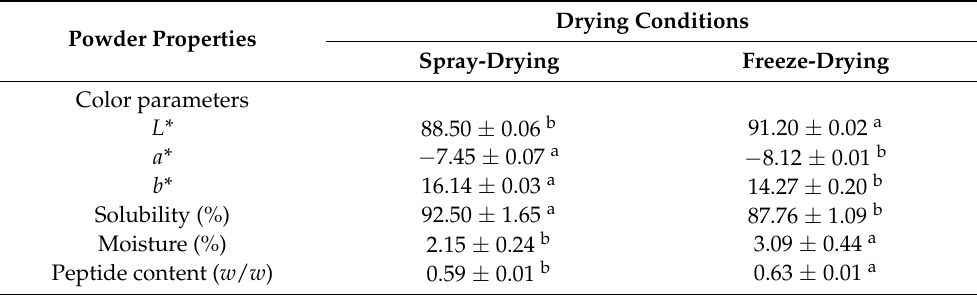
Table 2. Physical and chemical properties of chicken breast hydrolysate powder produced by Alcalase ® and followed by Papain (CBH:A-P) under different drying conditions 1 . Powder Properties